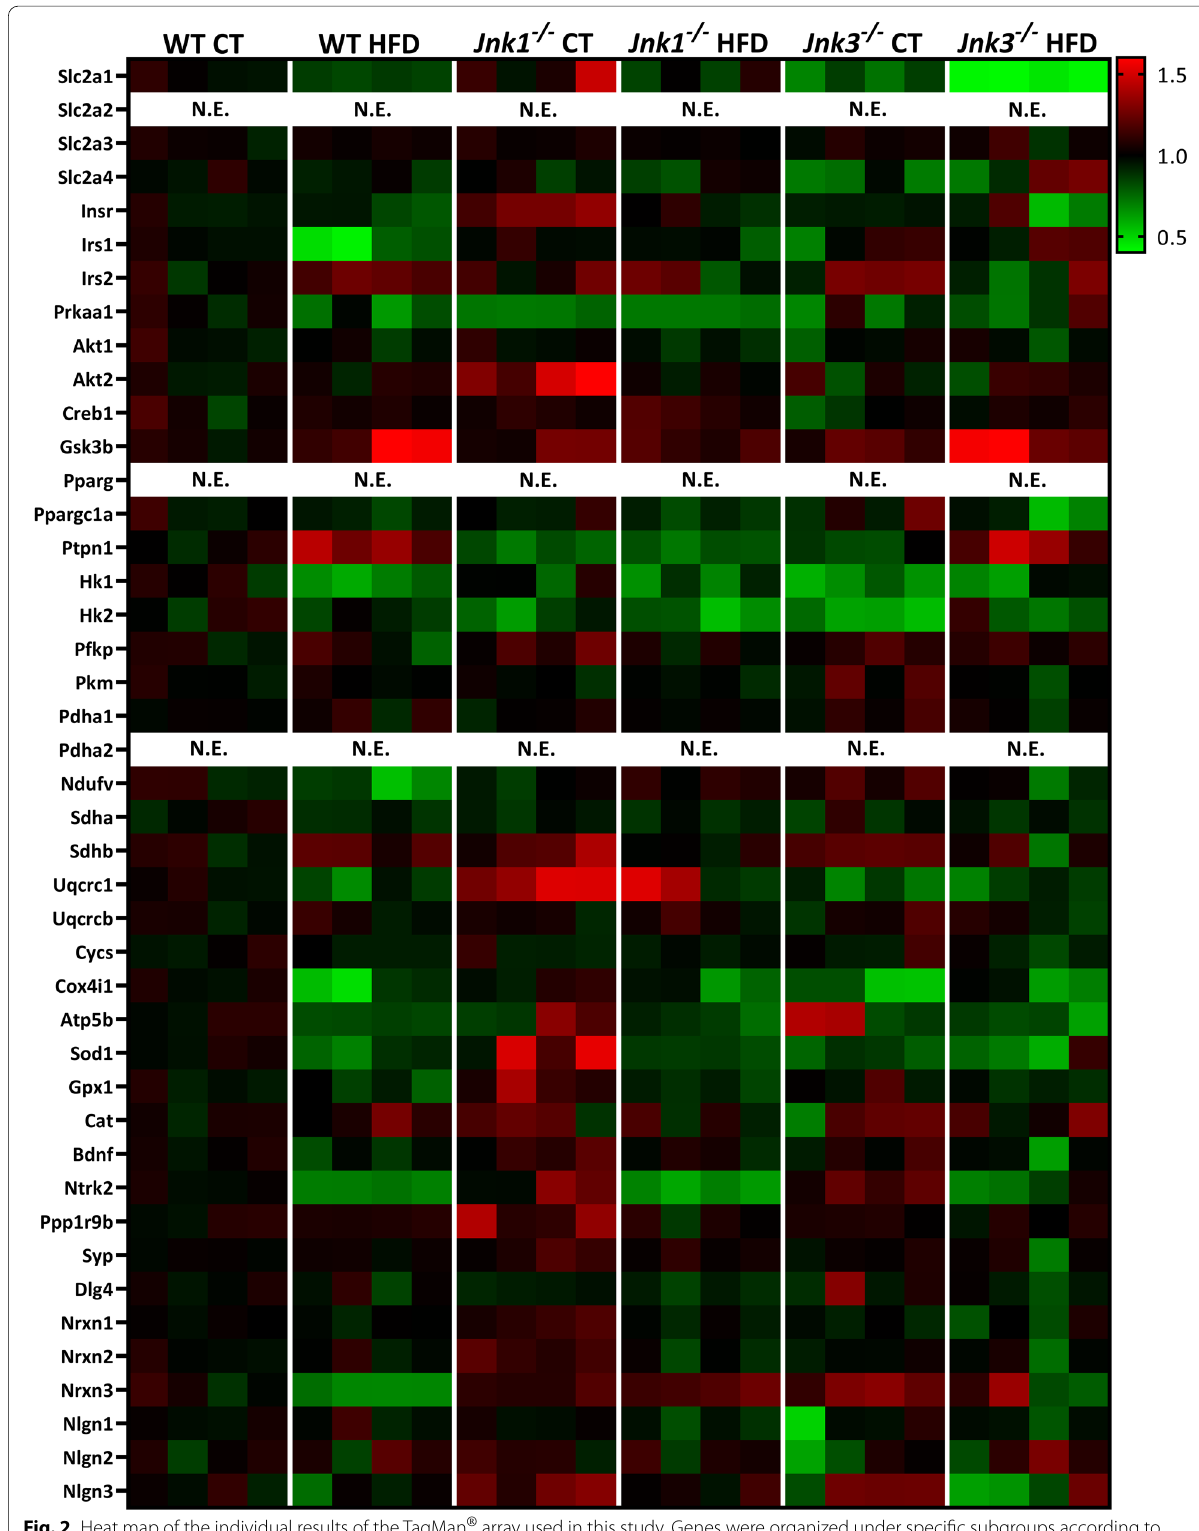
Fig. 2 Heat map of the individual results of the TaqMan ® array used in this study. Genes were organized under specific subgroups according to which pathway they belong to. Differences in genetic expression were calculated against the control experimental group. No data was reported for Slc2a2 , Pparγ and Pdha2 since the TaqMan ® probes produced either no signal or a C T value over 35. N.E. not expressed (n